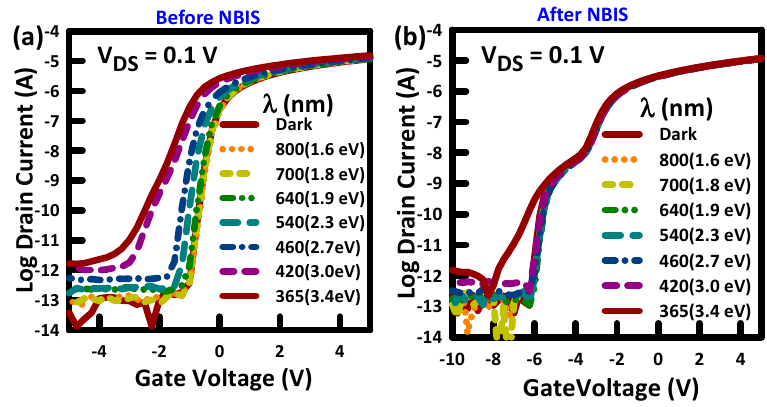
Figure 12. Effect of monochromatic light on the performance of amorphous indium-gallium zinc-oxide (a-IGZO) thin-film transistors (TFTs) ( a ) before and ( b ) after application of negative-gate bias stress combined with visible light illumination (NBIS).